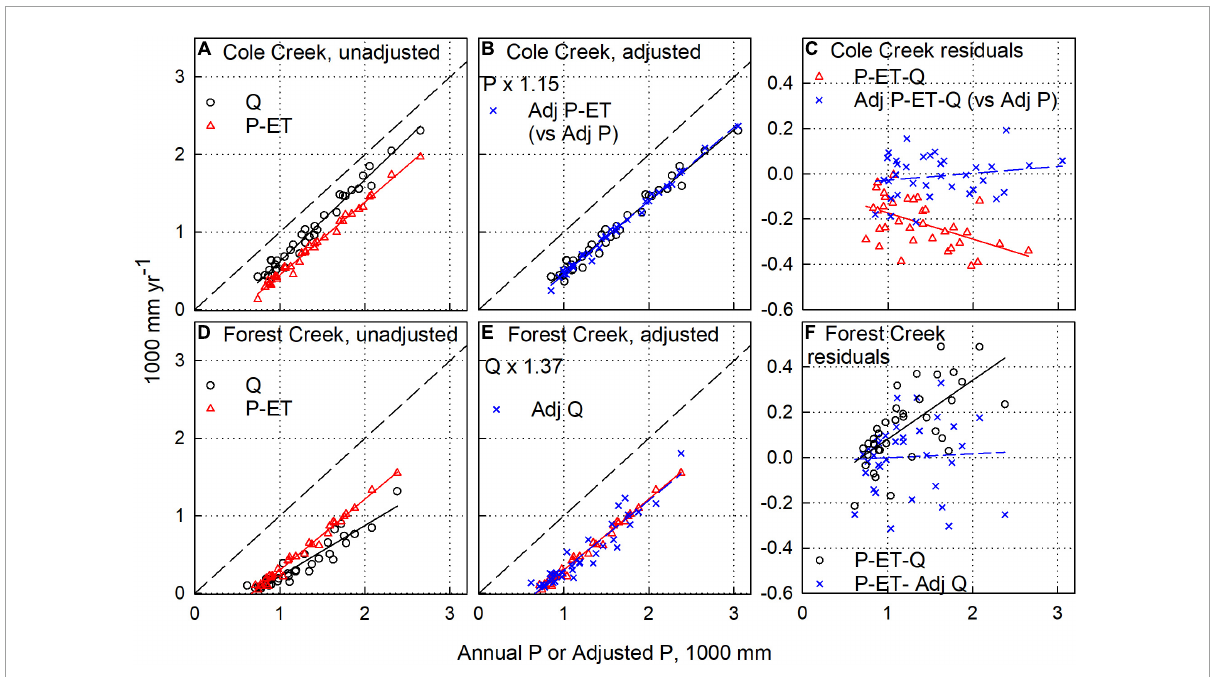
FIGURE2 Illustrated process to adjust water-balance components in Cole Creek near Salt Springs Dam (A–C) and Forest Creek near Wilseyville (D–F) watersheds. (A,D) Unadjusted annual water balance components discharge ( Q ) and precipitation minus evapotranspiration ( P-ET ) versus annual precipitation ( P ). (B) Adjusted P-ET and Q versus adjusted P (adj P ) for Cole Creek and (E) adjusted Q and P-ET versus P for Forest Creek. (C,F) Water-balance residuals ( P-ET-Q ) using unadjusted and adjusted